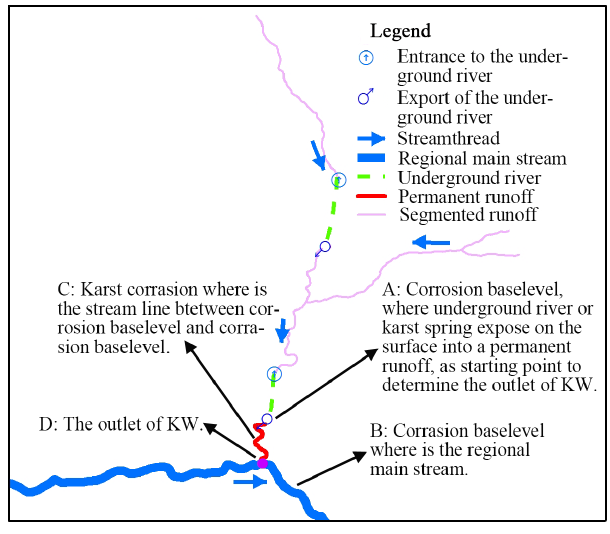
Figure 2. Schematic used to determine the outlet of karst water- sheds